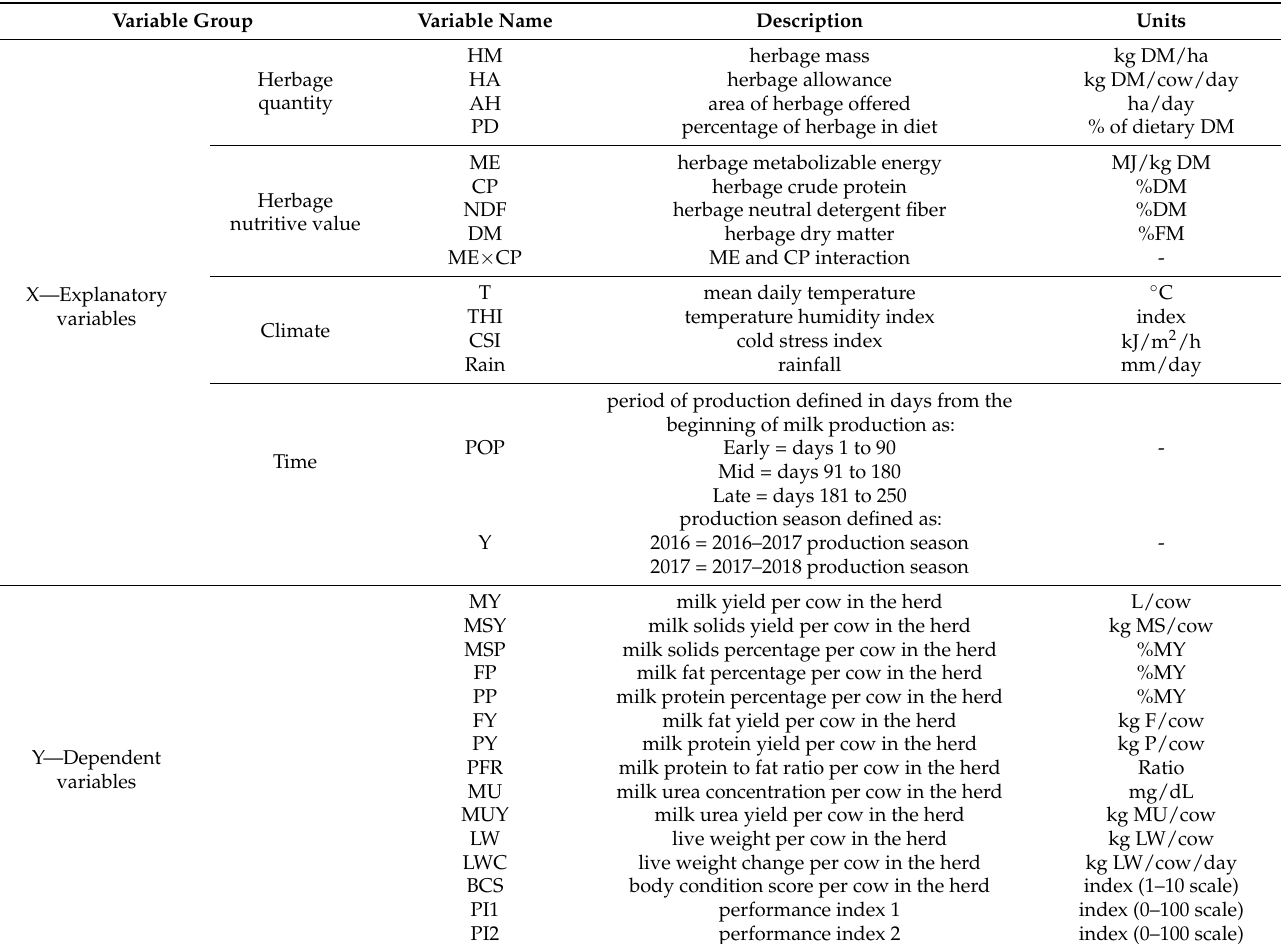
Table 1. Model variable list, description and